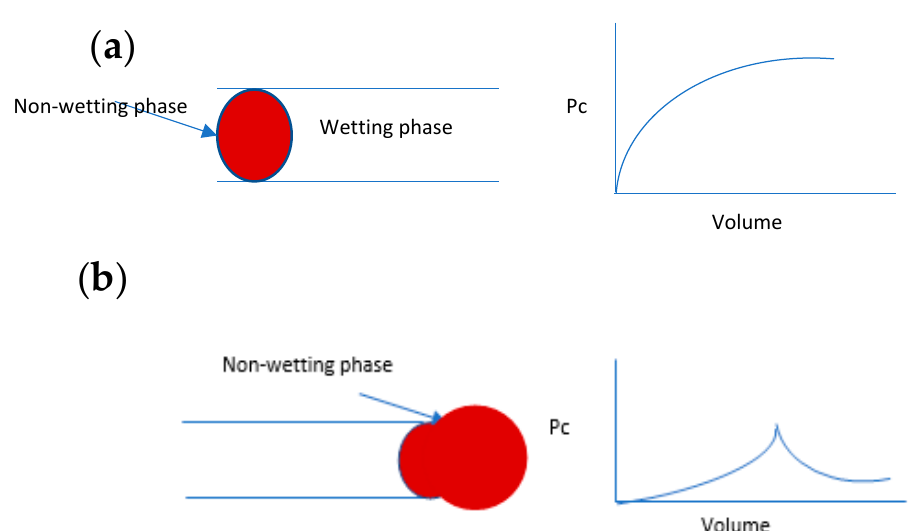
Figure 15. ( a ) Conceptual model of the movement of a non-wetting phase from the bulk reservoir to a narrowing pore throat, displacing a wetting phase. The capillary pressure increases up to the maximum value Pc given by Young–Laplace equation. ( b ) Movement of non-wetting phase from a channel to the bulk of the reservoir and the corresponding pressure profile.